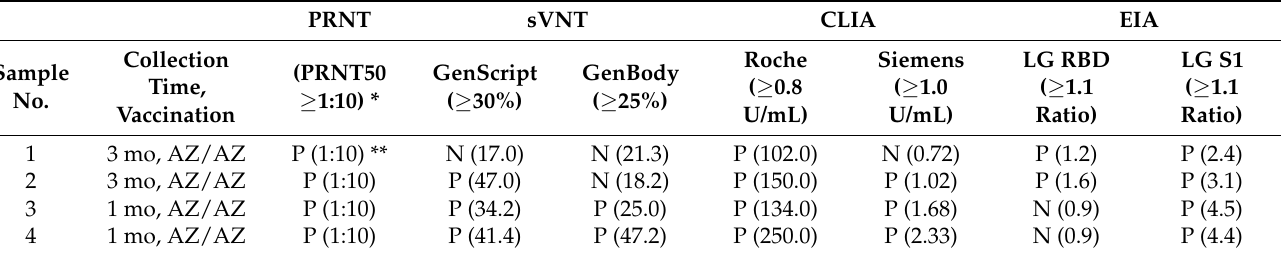
Table A3. SARS-CoV-2 antibody results for four samples with discrepancies among